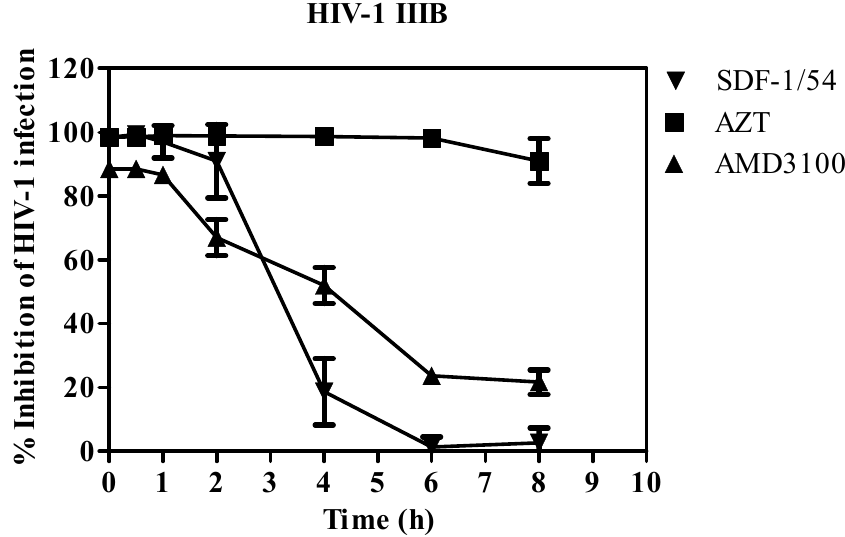
Figure 5. Inhibition of HIV-1 entry by SDF-1/54 as determined by the time-of-addition assay. SDF-1/54 was added to MT-2 cells at different intervals after infection with HIV-1 IIIB. AZT and AMD3100 were included as controls. The final concentration was 800 nM for SDF-1/54, 100 nM for AZT and 400 nM for AMD3100. Averages (±SD) from three independent experiments are shown.